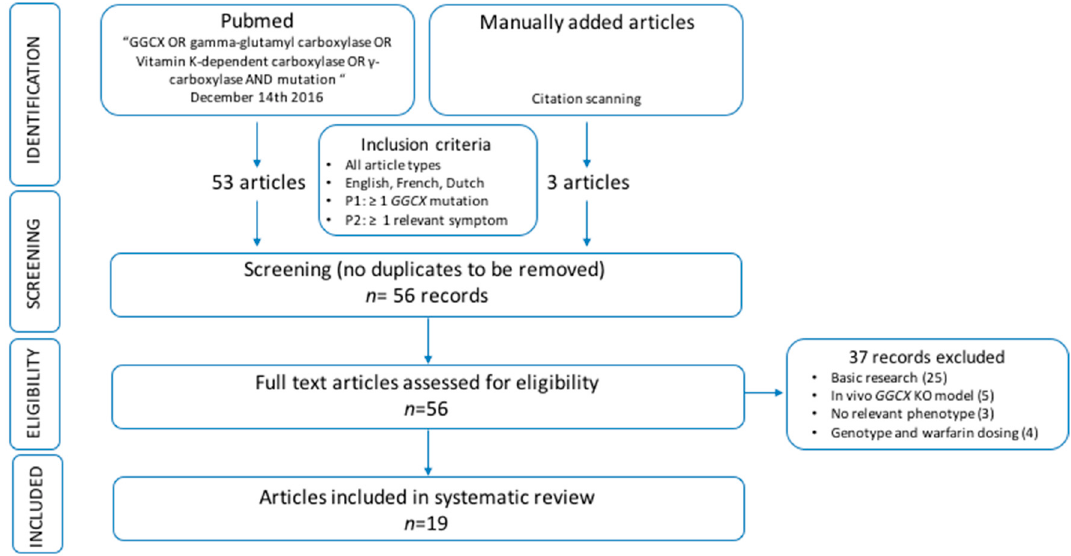
Figure 4. Overview of the pipeline used for the systematic search of the literature. GGCX: gamma-glutamyl